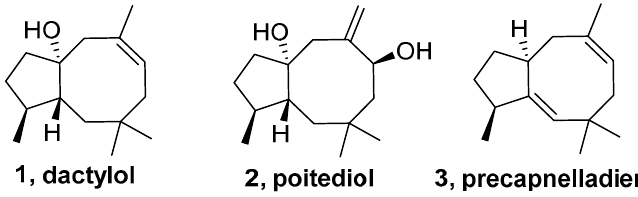
Figure 2. Structures of precapnellane-sesquiterpenoids.